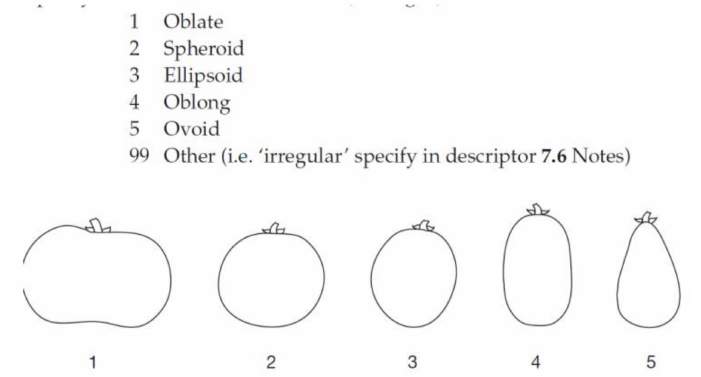
Figure 1. Various shapes of shea kernel (INIA,